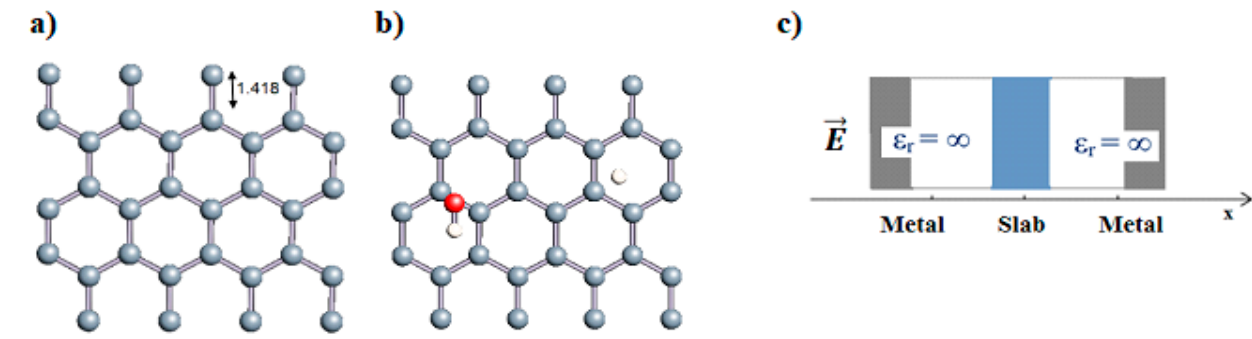
Figure 1. ( a , b ) Graphene and dissociated water + graphene system. ( c ) ESM method model.